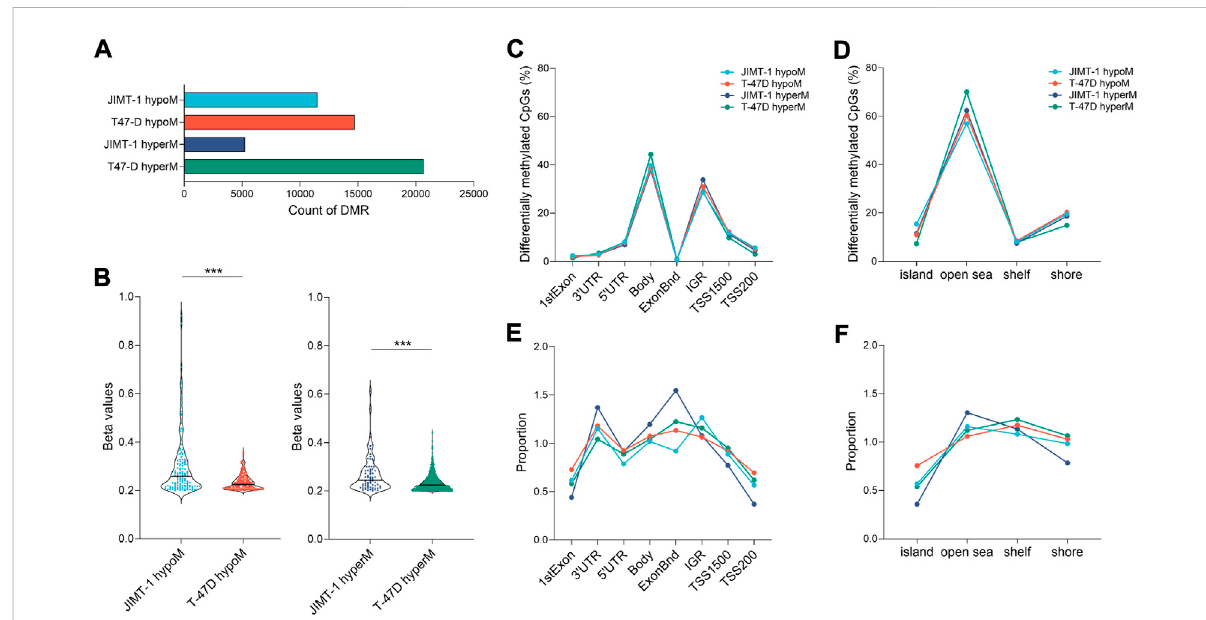
FIGURE 4 Extend of DNA methylation changes in studied cell lines. (A) The number of hypo- and hypermethylated CpGs in JIMT-1 and T-47D cell lines ( p -value ≤ 0.01); (B) Violin plots showing spread out the Δ β beta values ( ≥ 0.2) for differentially hypo- and hypermethylated probes ( p -value ≤ 0.01) identi fi ed between treated and control JIMT-1 and T-47D cells, *** p < 0.001; Distribution of DAC-induced DNA methylation changes ( p -value ≤ 0.01) across the (C) functional and (D) regulatory regions in the genome and (E, F) their normalization to the number of analyzed